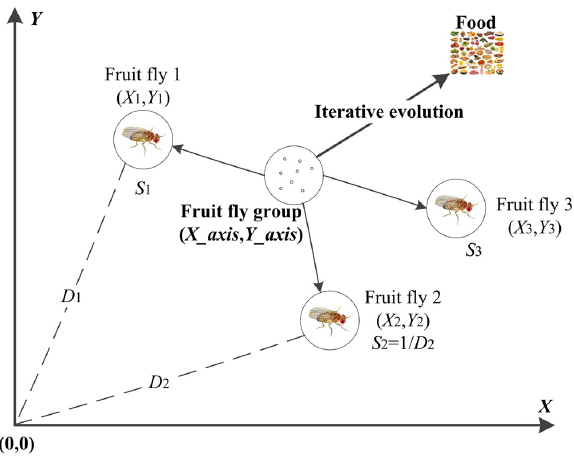
Figure 1. Foraging process of fruit fly swarm.